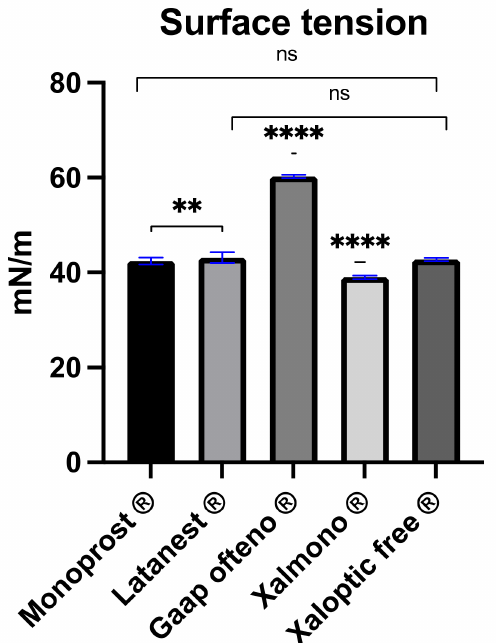
Figure 3. Surface tension characterization of preservative-free 0.005% latanoprost products; Monoprost ® , Latanest ® , Gaap Ofteno ® , Xalmono ® and Xaloptic ® Free. Values are listed as mean ± SD, n = 3. A one- way ANOVA with a Tukey multiple-comparison test ( p = 0.05) were performed. ns = not significant with p ≥ 0.05, ** p ≤ 0.01, **** p ≤